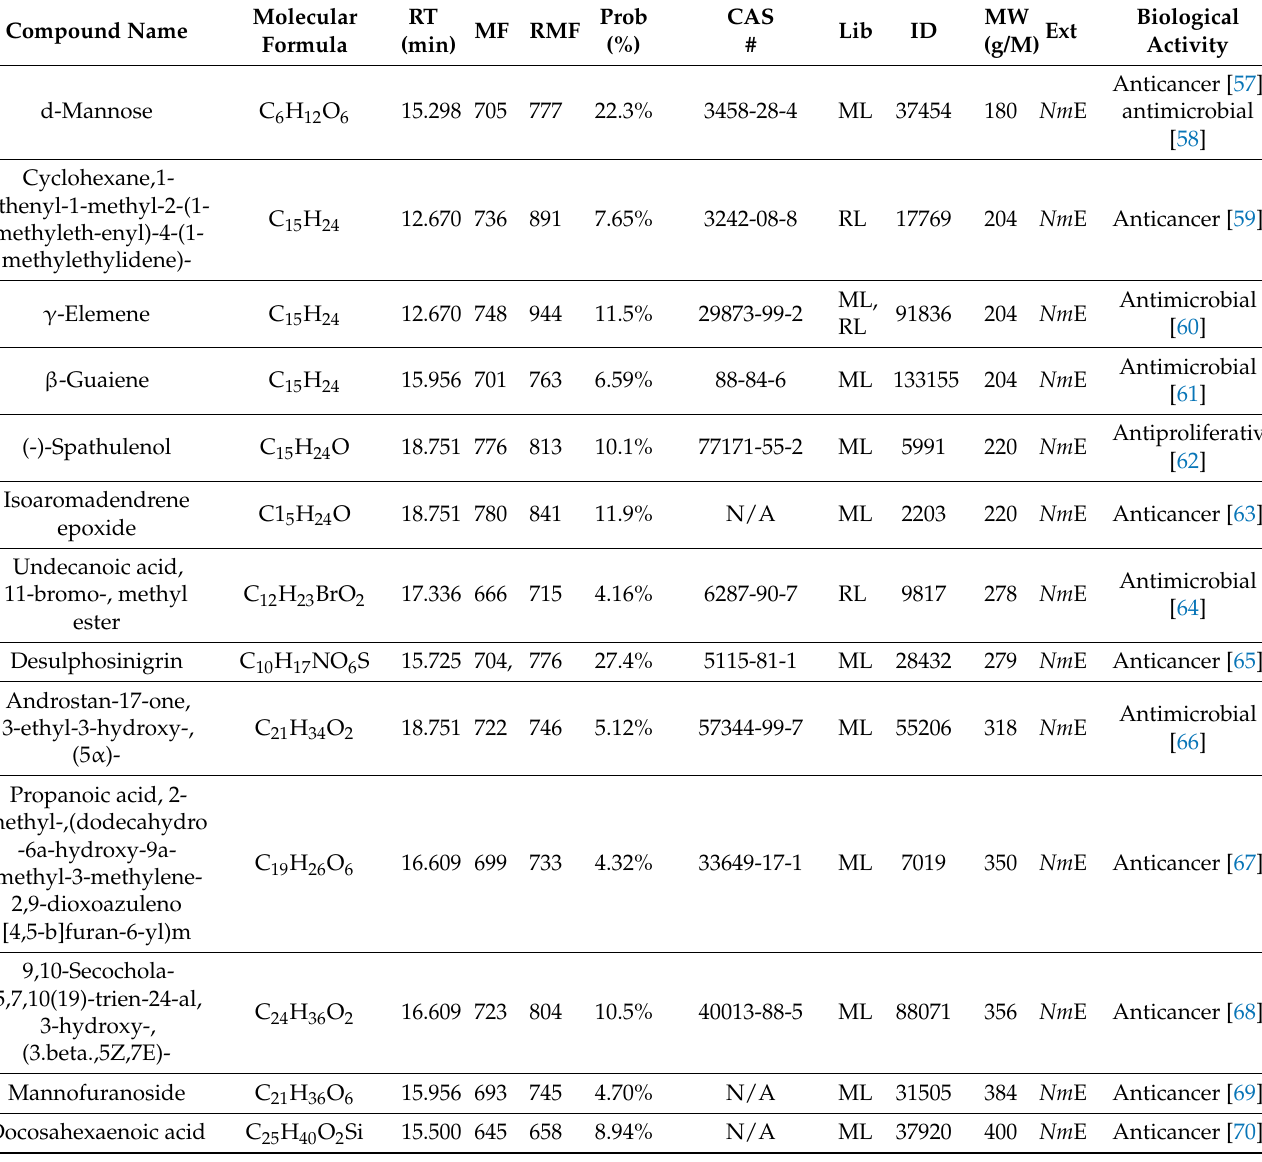
Table 1. Bioactive compounds of GC–MS analysis of Cs E and NmE , with the reported biological activities of each compound